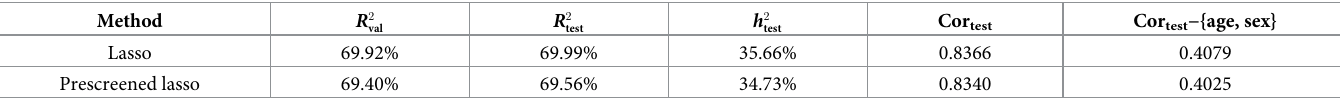
Table 2. Comparison of prediction results on height with the model trained following the same procedure as ours except for an additional prescreening step as done in [21]. In addition to R 2 , proportion of residual variance explained (denoted by h 2 ) and correlation between the fitted values and actual values are computed. We also test compute an adjusted correlation between the residual after regressing age and sex out from the prediction and the residual after regressing age and sex out from the true response, both on the test set. Method R 2 R 2 val test Lasso